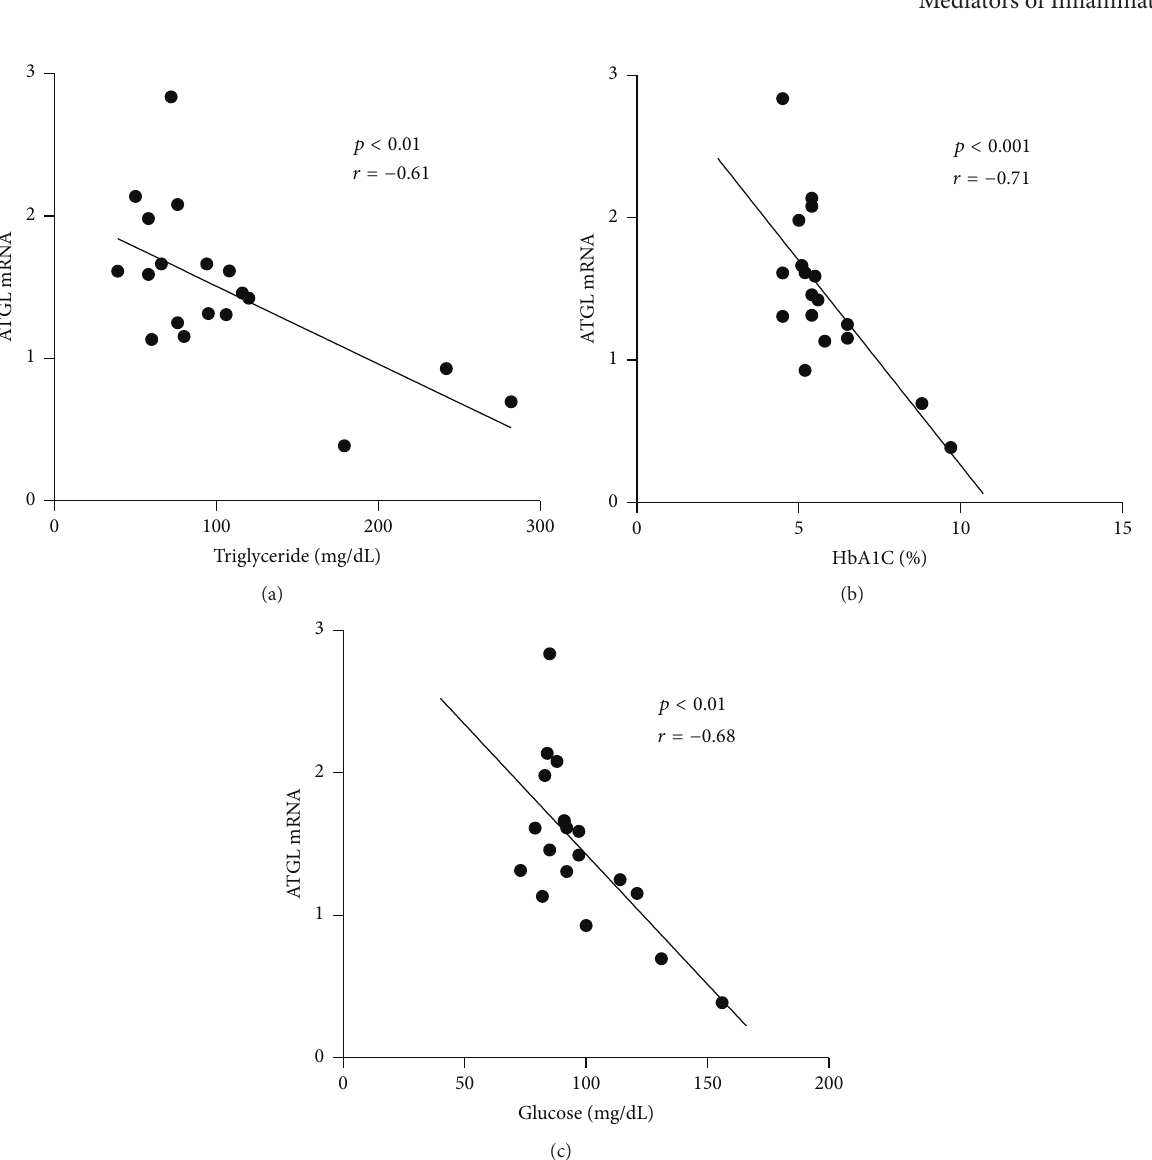
Figure 2: Correlations between ATGL mRNA and clinical parameters. (a) ATGL mRNA expression inversely correlated with plasma triglycerides after weight loss ( 𝑝 < 0.01 , 𝑟 = −0.61 ). (b) ATGL mRNA inversely correlated with plasma HbA1C ( 𝑝 < 0.001 , 𝑟 = −0.71